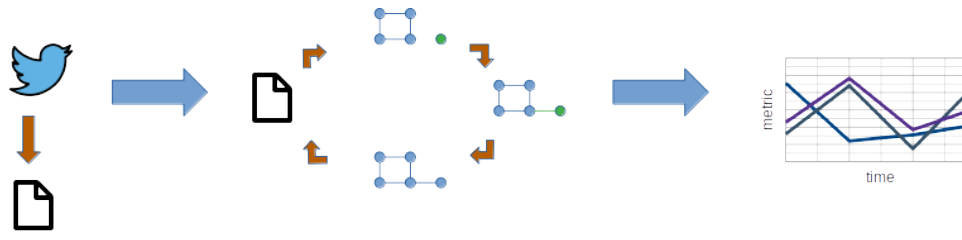
Figure 1. Extraction, generation, and analysis